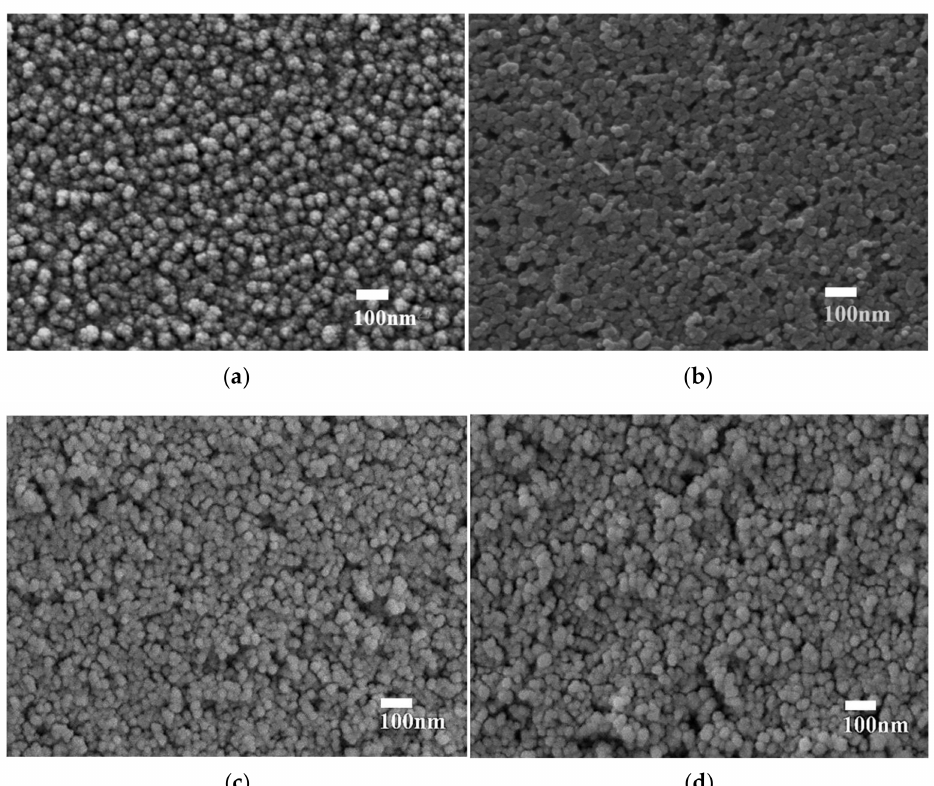
Figure 6. SEM photographs of the mixed Acac (0–3 mL) with a TiO 2 mesoporous layer. ( a ) Acac 0 mL TiO 2 mesoporous,